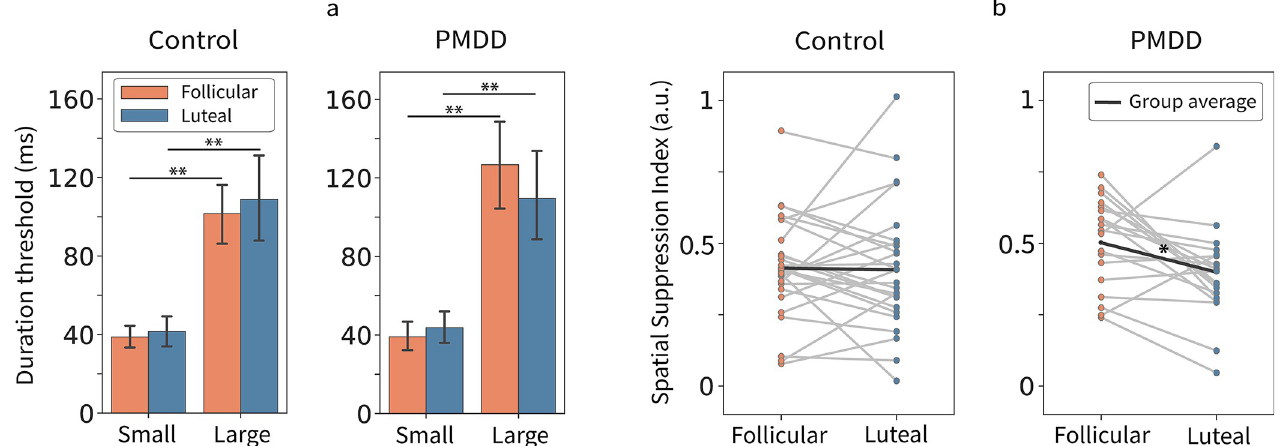
Fig 7. Dependence of motion direction distinction on the phase of the menstrual cycle (follicular, luteal phase) in control and PMDD participants. (a) duration thresholds for the small and large stimuli (b) and spatial suppression index (SSI). Error bars represent 95% confidence intervals. � p < 0.05; �� p < 10 − 8 .